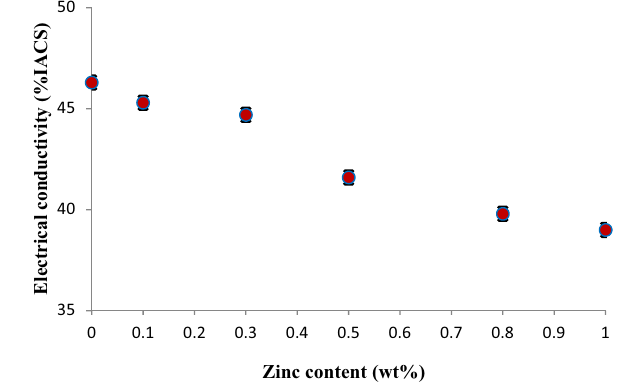
Fig. 2 Electrical conductivity of silicon bronze with varying zinc nano-particles